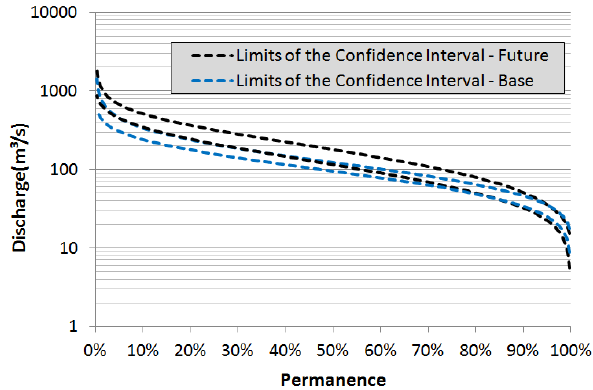
Figure 8. 90% confidence interval for the monthly flow perma- nence curves, according to the stochastic series generated in the base (1961–1990) and future periods (2011–2040), at Santo Ângelo gauge